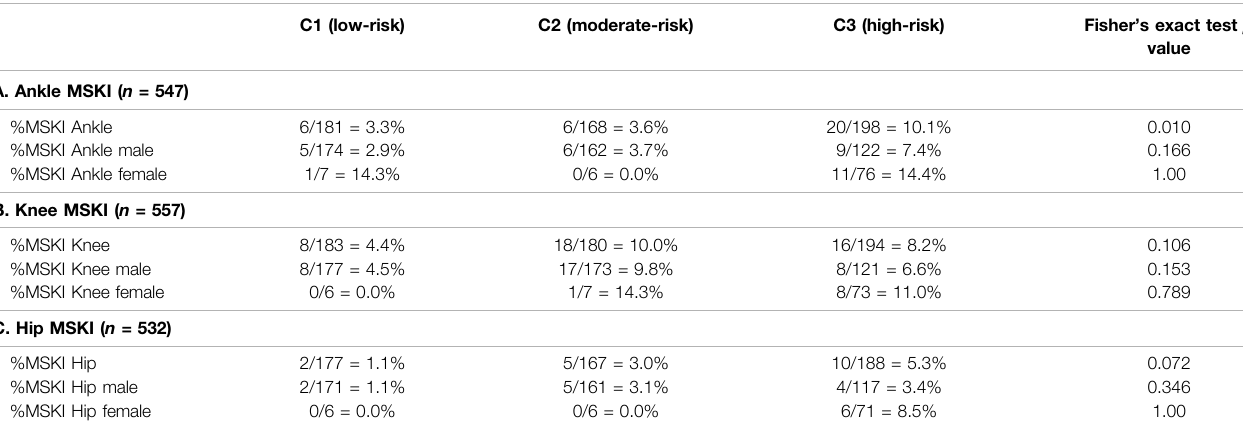
TABLE 5 | Proportions of MOCs with Joint Musculoskeletal Injury by